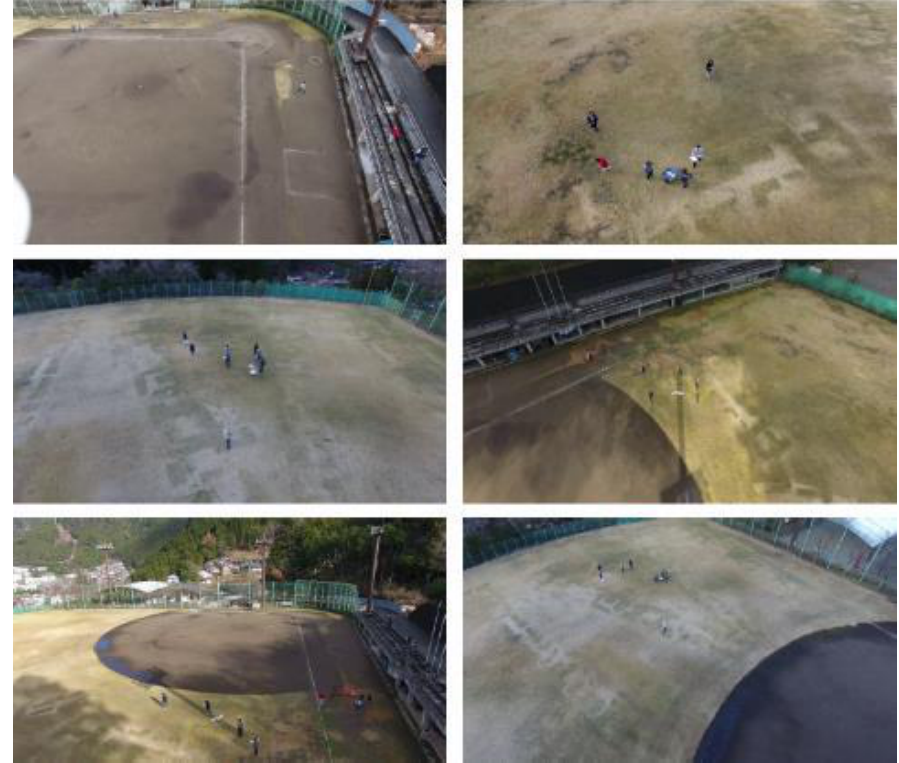
Figure 31. Dataset sample images.